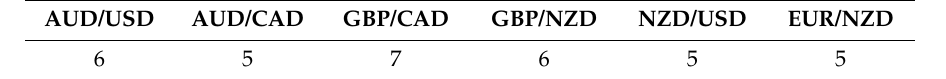
Table 9. Number of times that MDD Trading has exceeded MDD Training for each of the six considered currency pairs (based on the risk management module described in Section 5.3).